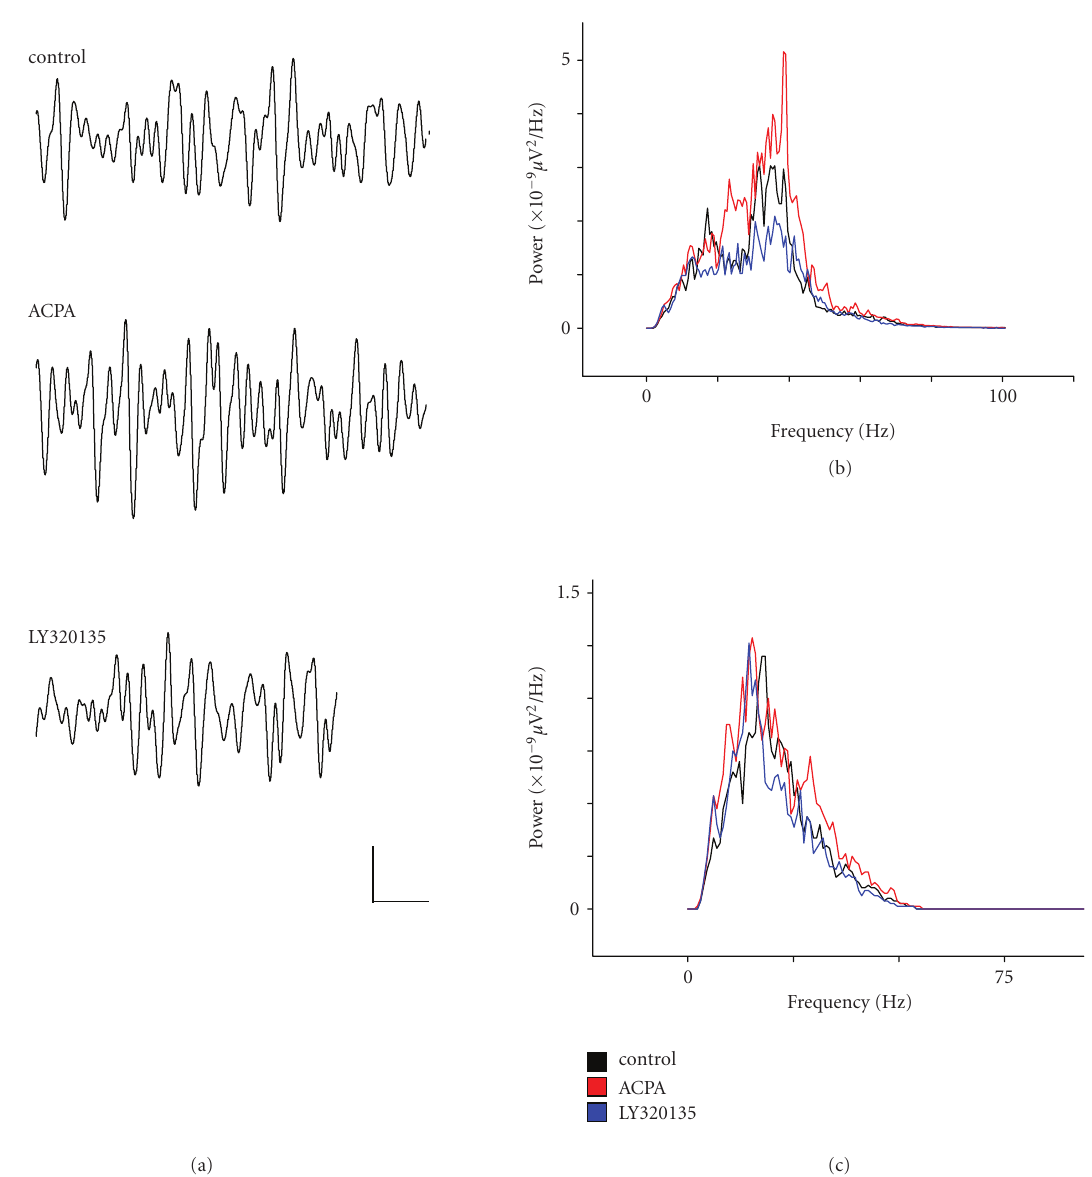
Figure 2: The e ff ects of ACPA and LY320135 on β -band activity in mEC layer II. (a) Example traces from layer II showing β -oscillations under conditions in which ACPA (10 μ M) or LY320135 (500nM) were applied. (b) Plot of power spectral density during drug application (filtered between 2–100 Hz). Control (black line), ACPA (red line), LY320135 (blue line). (c) Similar plot to (b) bandpass filtered between 15–29 Hz. Scale bar = 200 milliseconds × 50 μ